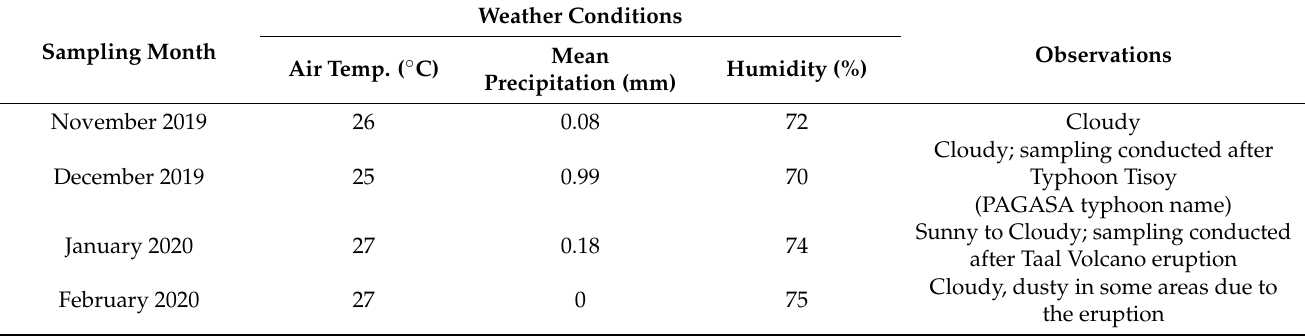
Table 3. Weather conditions and observations during the sampling period